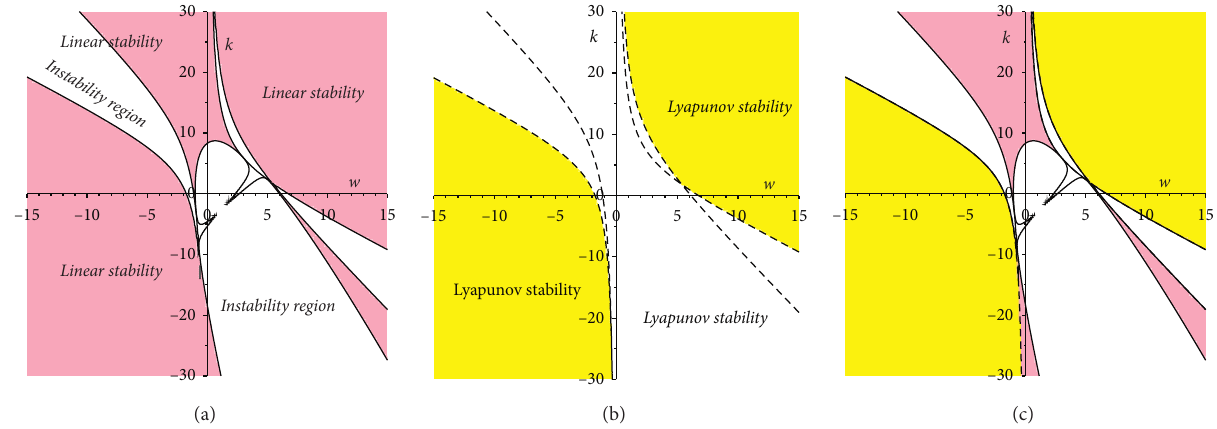
in the plane of the two parameters k and ω and 1